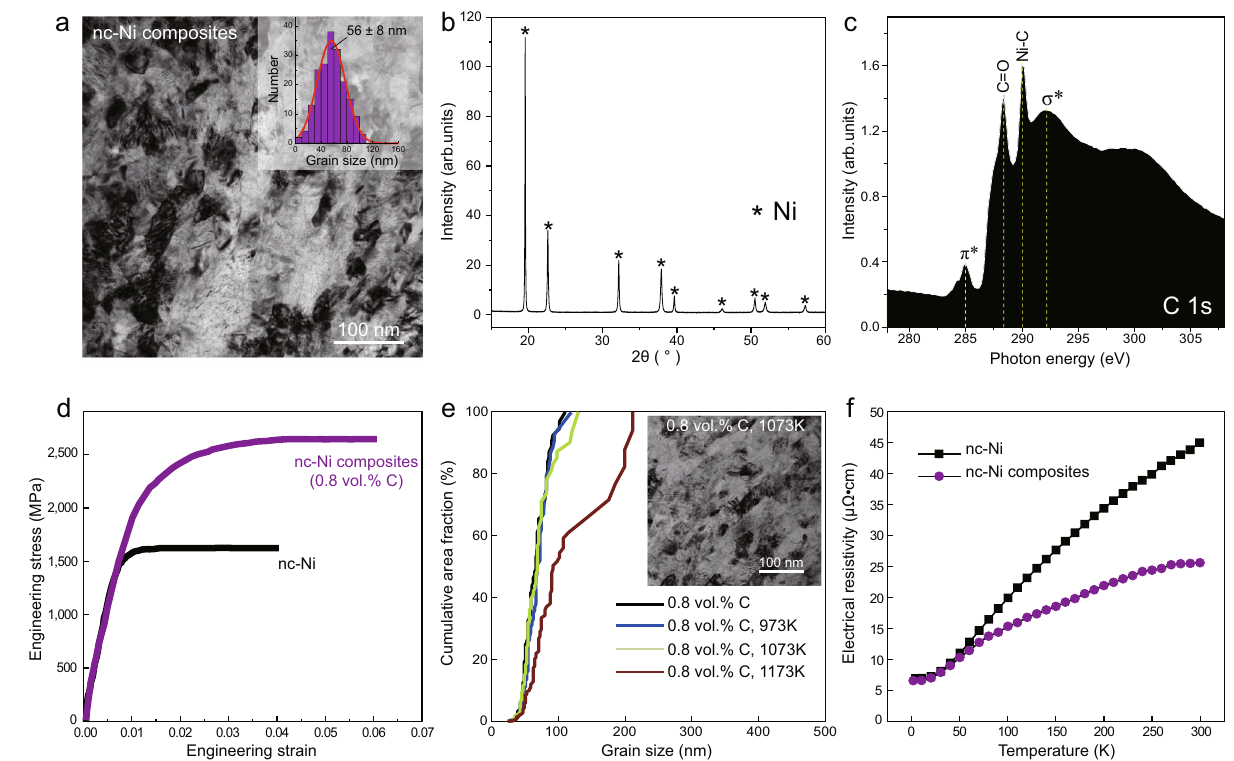
Fig. 5 | Microstructure, tensile properties, and thermal stability of pure nc-Ni andnc-Ni composite.a Abright- fi eld TEM imageofnc-Nicomposite (0.8vol.% C). Inset shows the Ni grain size distribution of the composite. The grain size of nc-Ni obtainedwiththeidenticalfabricationprocessis61±10nm .b SXRDpatternofthe composite. Note that no Ni-C compounds are observed in SXRD experiments. c NEXAFSspectrumattheC-Kedgeofnc-Nicomposites(0.8vol.%C).Ni-Cchemical bond, which corresponds to the absorption peak at 290.3eV, is identi fi ed. d Representative tensile engineering stress-strain curves for nc-Ni and nc-Ni com- posites. Simultaneous enhancement of yield strength, fracture strength, and